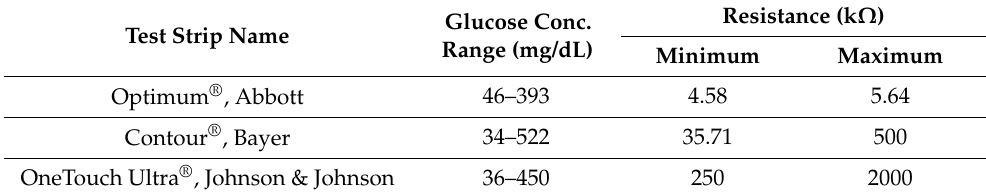
Table 3. The concentration ranges and the equivalent resistance variation of glucose